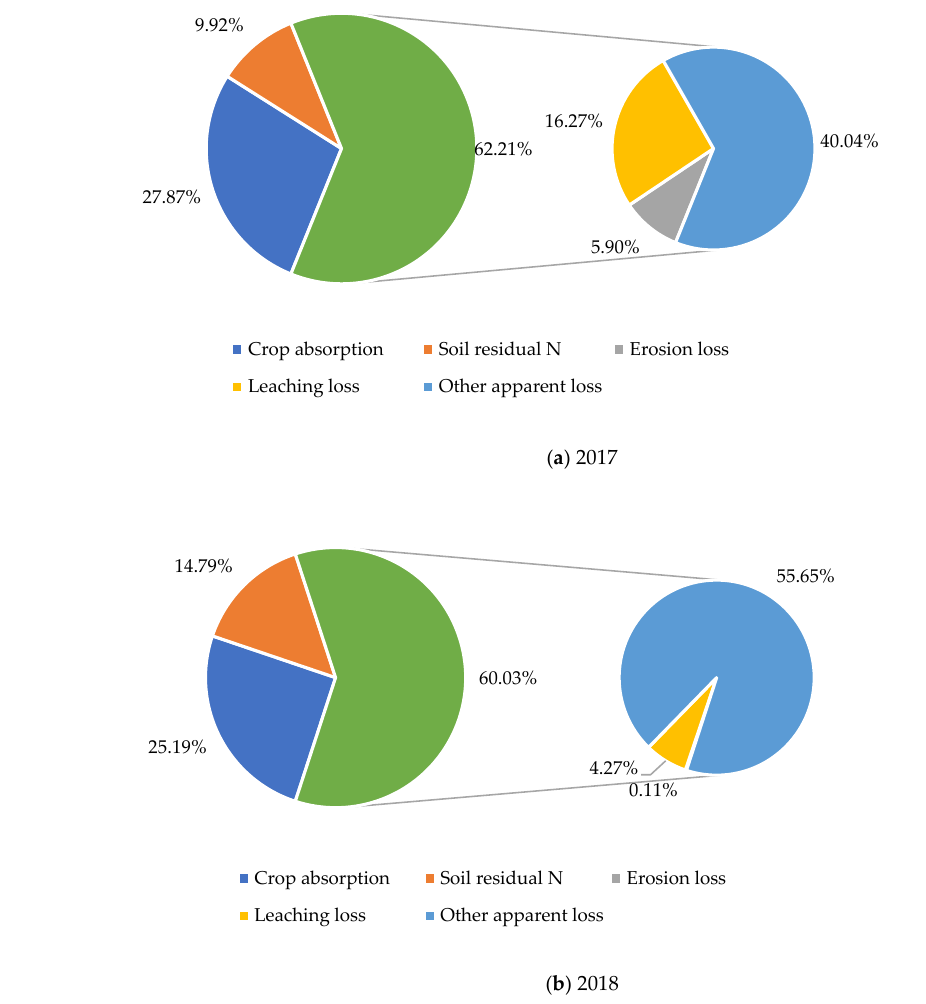
Figure 2. The apparent fate of fertilizer N in peanut-growing season. Note: The values represent the proportion of N in different directions in 2017 ( a ) and 2018 ( b ). The pie chart on the left shows the proportion of the fertilizer N ’ s apparent fate through crop absorption, soil residual N, and apparent N loss. The pie chart on the right shows the proportion of fertilizer N loss through ero- sion, leaching, and other apparent loss (gaseous loss, etc.).